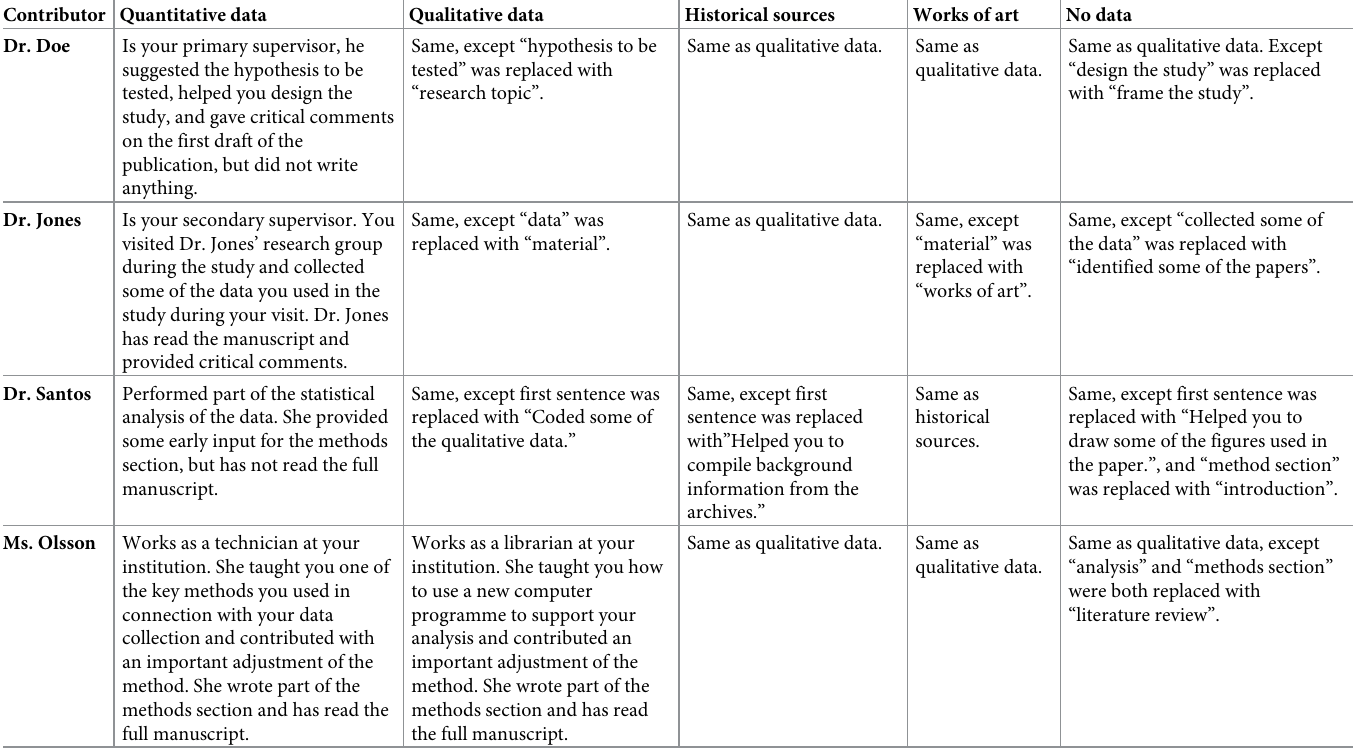
Table 4. Descriptions of the contributions of different collaborators in the authorship